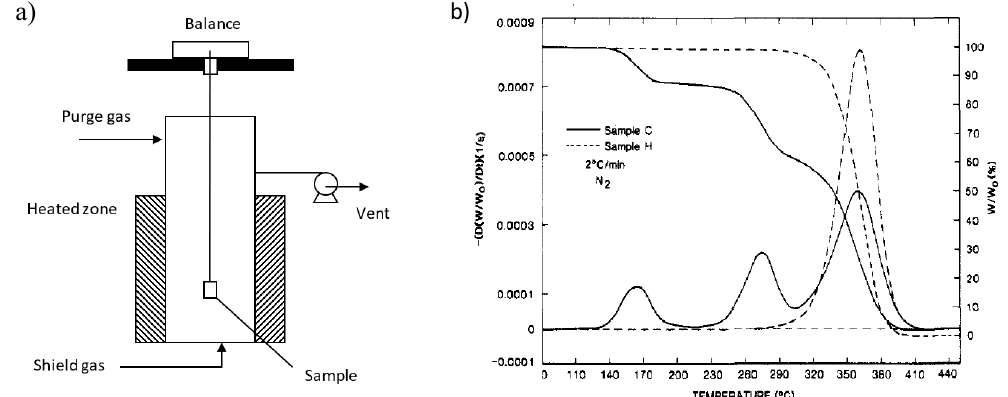
Figure 7. ( a ) Schematic representation of thermogravimetric analysis (TGA) instrument, ( b ) more complex overall degradation mechanism for poly(methyl methacrylate) (PMMA) made by free radical polymerization (FRP) as compared to PMMA made by anionic polymerization (AP); comparison of mass loss (here symbol W) for sample C (FRP) and sample H (AP) using TGA and differential thermal analysis (DTG) analysis; reproduced with the permission from ACS [28].